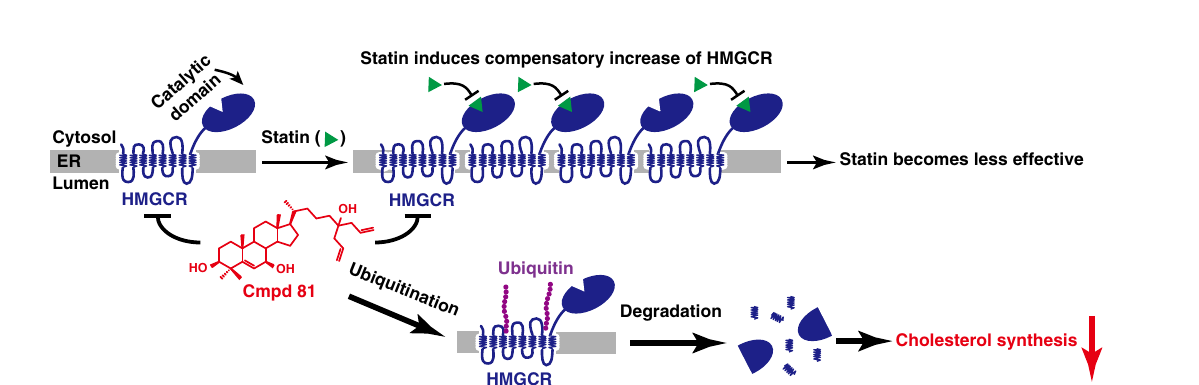
Fig. 7 A working model of Cmpd 81 in lowering cholesterol synthesis. All clinically used statins dramatically induce compensatory increase of HMGCR, and the increased HMGCR proteins would blunt statins ’ ef fi cacy. However, Cmpd 81 remarkably degrades statins-induced HMGCR protein through the ubiquitin-proteasome pathway to lower the cholesterol synthesis, and to improve the ef fi cacy of